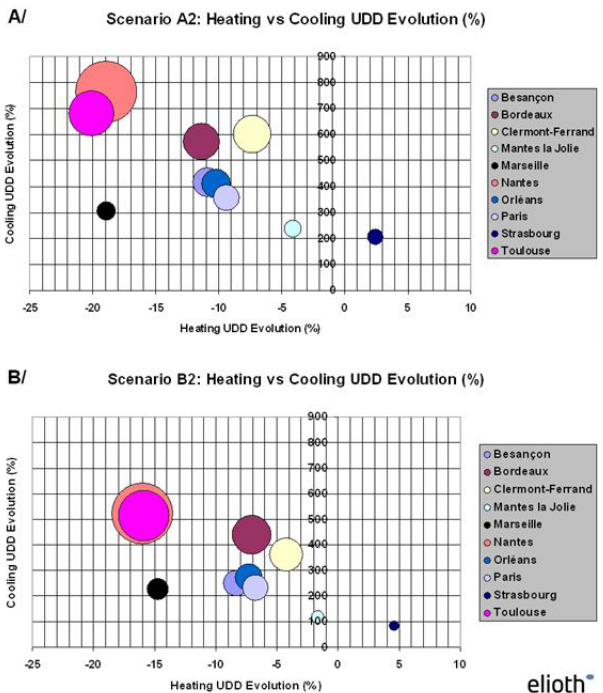
Fig. 8. Evolution of heating and cooling needs (Unified Degree Day or UDD) from 1996–2005 to 2050–2100 periods (Bubble diameters function of the evolution of number of hours where temperature is above 28 ◦ C: +50% in the legend). (A) Scenario A2, (B) Scenario B2.